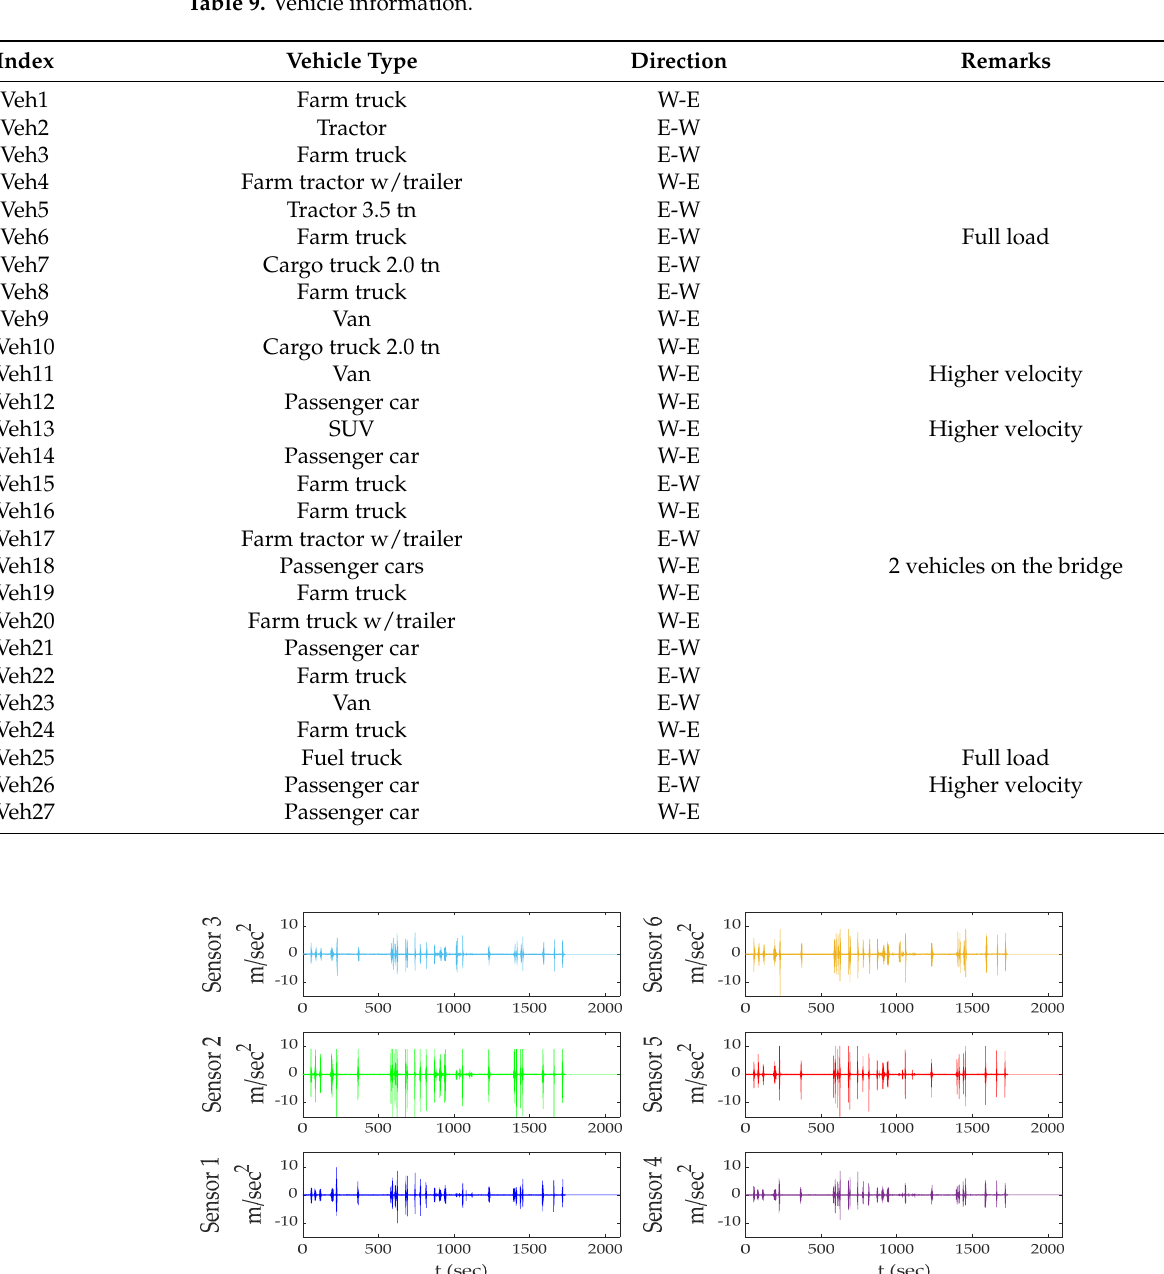
Table 9. Vehicle information.